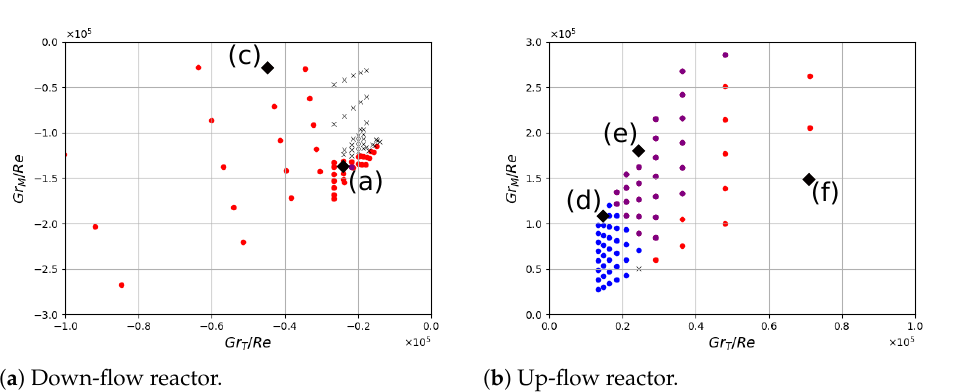
Figure 5. Instabilities in terms of thermal and molar Grashof numbers over the Reynolds number. Black cross I ( Ω HVPE ) = 0. Red dots: I ( Ω Out ) > 0. Blue dots: I ( Ω In ) > 0. Violet dots: I ( Ω In ) × I ( Ω Out ) > 0 . Markings ( a ),( c )–( f ) refer to Figure 4.